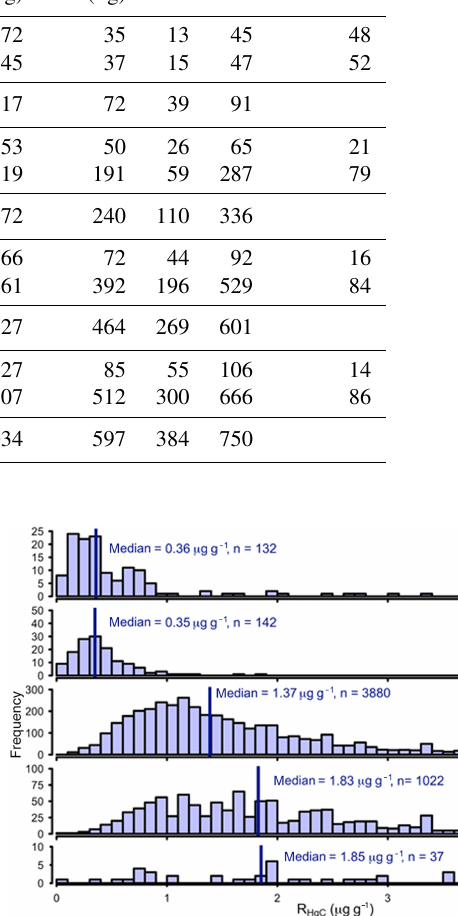
Figure 9. Histograms and median R HgC for the 0–30cm soil inter- val for different global climate